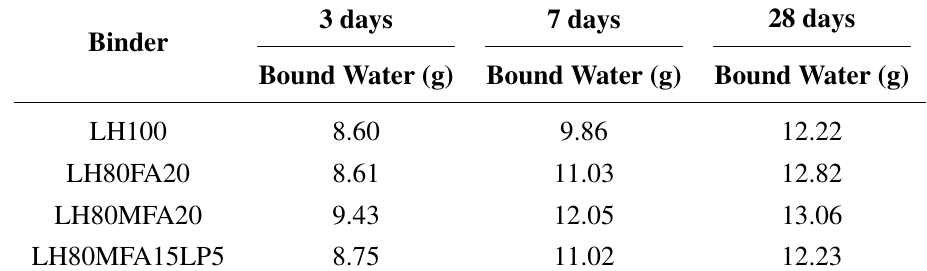
Table 5. Amount of bound water per 100 g of LHC.